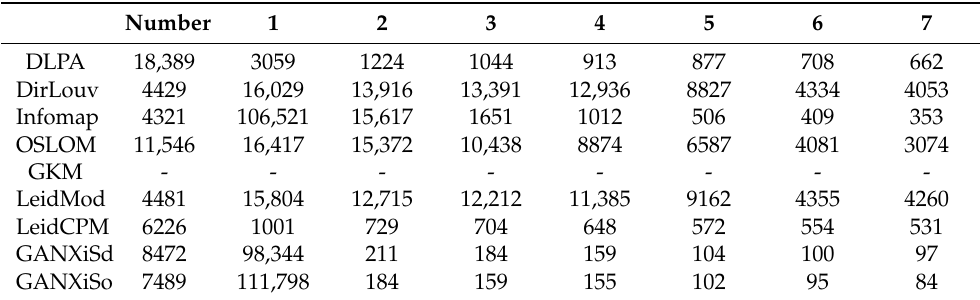
Table 6. The number of communities obtained on the Ferguson dataset and the value of the seven largest of them for each algorithm.